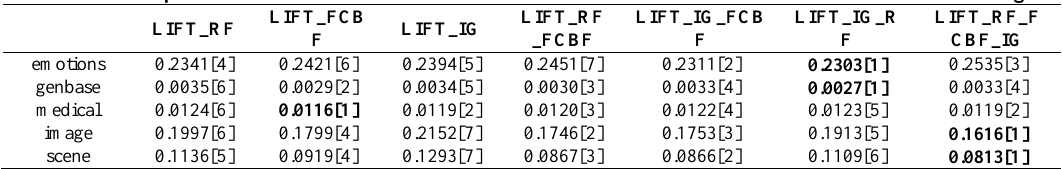
Table 2. The comparison of different ensembles of the three feature selection methods in terms of hamming loss